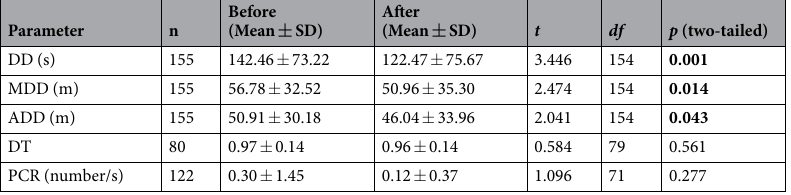
Table 4. Paired sample t test of the difference in the parameters of penguin dives between before and after a calling bout within three minutes. Significant variables are denoted in bold. DD = Dive duration, MDD = Maximum dive depth, ADD = Average dive depth, DT = Dive type, PCR = Prey capture